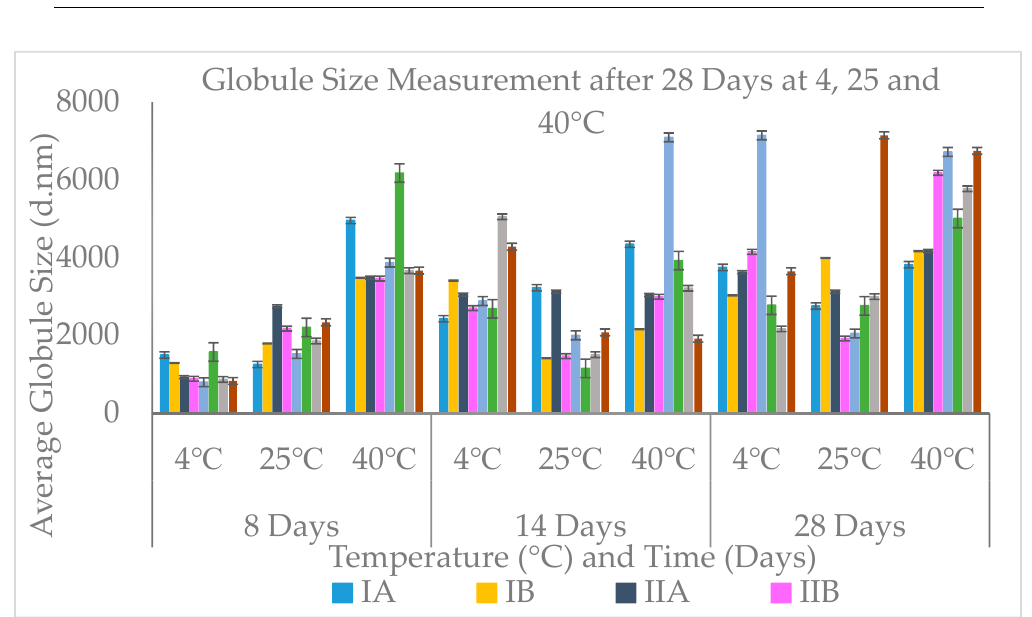
Figure 3. Globule size measurement after 8, 14 and 28 days at 4, 25 and 40 ◦